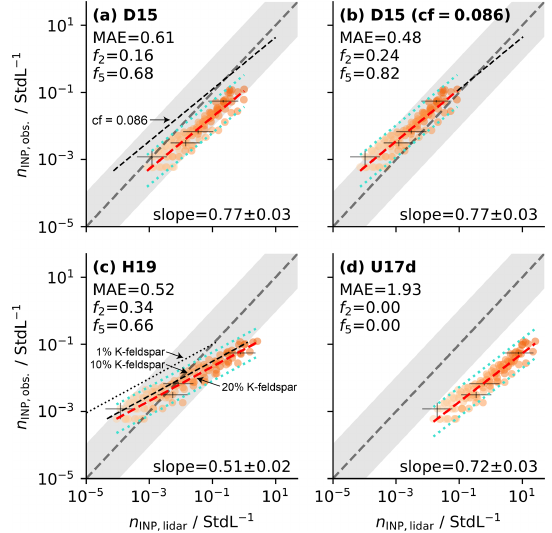
Figure 4. Comparison of in situ INP concentrations ( n INP , obs . ) measured at WFJ (mountaintop site, Fig. 1) to lidar-retrieved INP concentrations ( n INP , lidar ) during the Saharan dust event (19–21 February 2019) for three dust parameterizations: (a) D15 (DeMott et al., 2015), (b) D15 with a calibration factor (cf = 0 . 086) ap- plied as proposed by Schrod et al. (2017), (c) H19 (Harrison et al., 2019), and (d) U17d (Ullrich et al., 2017). Notably, we compare INP concentrations at temperatures between − 20 ◦ C (dark orange) and − 5 ◦ C (light orange). The 1 : 1 line is shown in dashed gray. The dashed red lines show a linear regression fit through the loga- rithmically transformed data points, including the 95% confidence interval in dotted cyan. Shown in every panel are the mean abso- lute error (MAE), the fraction of data points falling within a fac- tor of 2 and 5 with respect to the 1 : 1 line ( f 2 and f 5 ), and the slope of the fit (including the standard error). The gray shaded area indicates a deviation of 1 order of magnitude from the 1 : 1 line, which is the upper limit uncertainty of the lidar-based INP retrieval (Mamouri and Ansmann, 2016). For D15 (a) , the data fit is also presented, applying the calibration factor from (b) for comparison (black dashed). For H19 (c) , the data fit is also presented, assuming a K-feldspar fraction of 10% (black dashed) and 1% (black dot- ted), respectively. Uncertainties in INP concentration are indicated for representative samples in